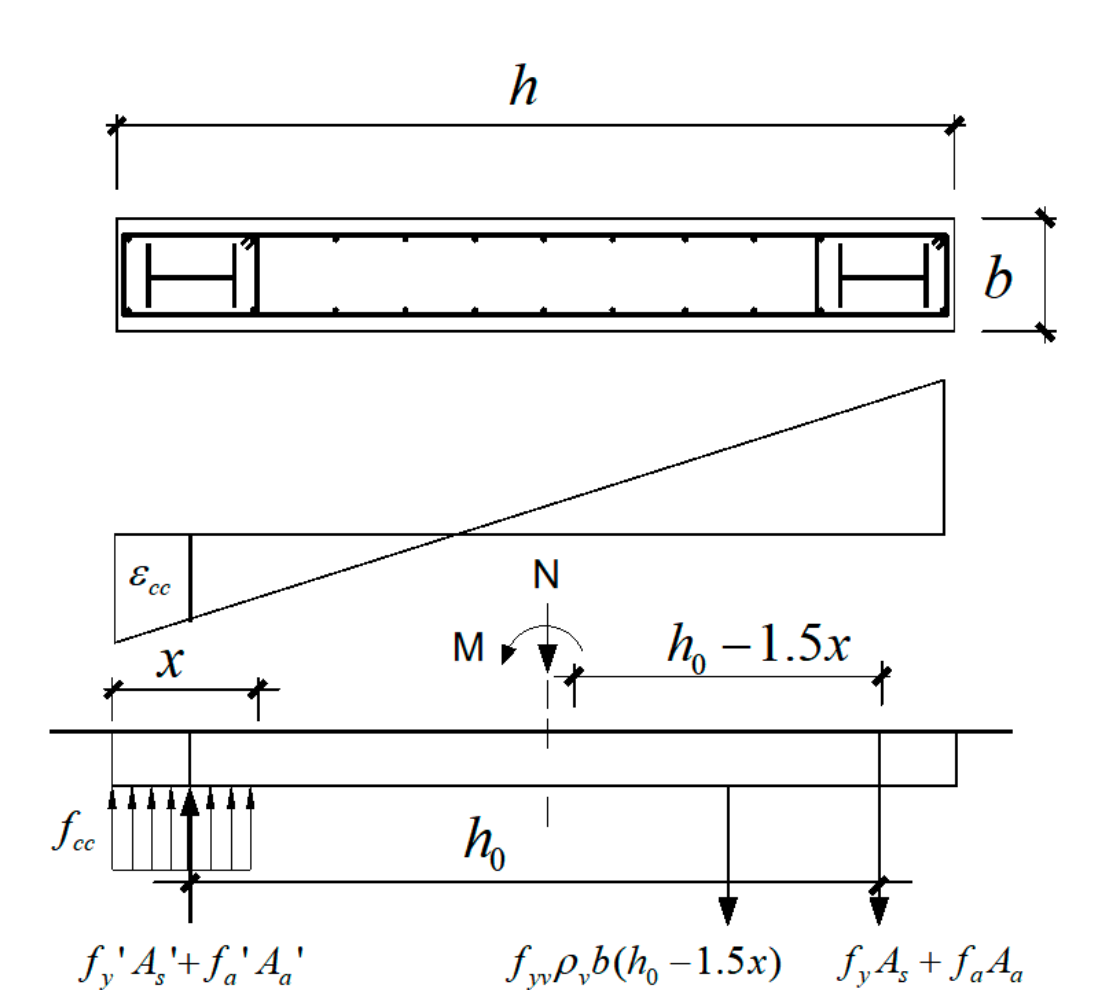
Figure 10. The force equilibrium diagram of a prefabricated concrete shear wall with steel sections in the ultimate bearing capacity state.